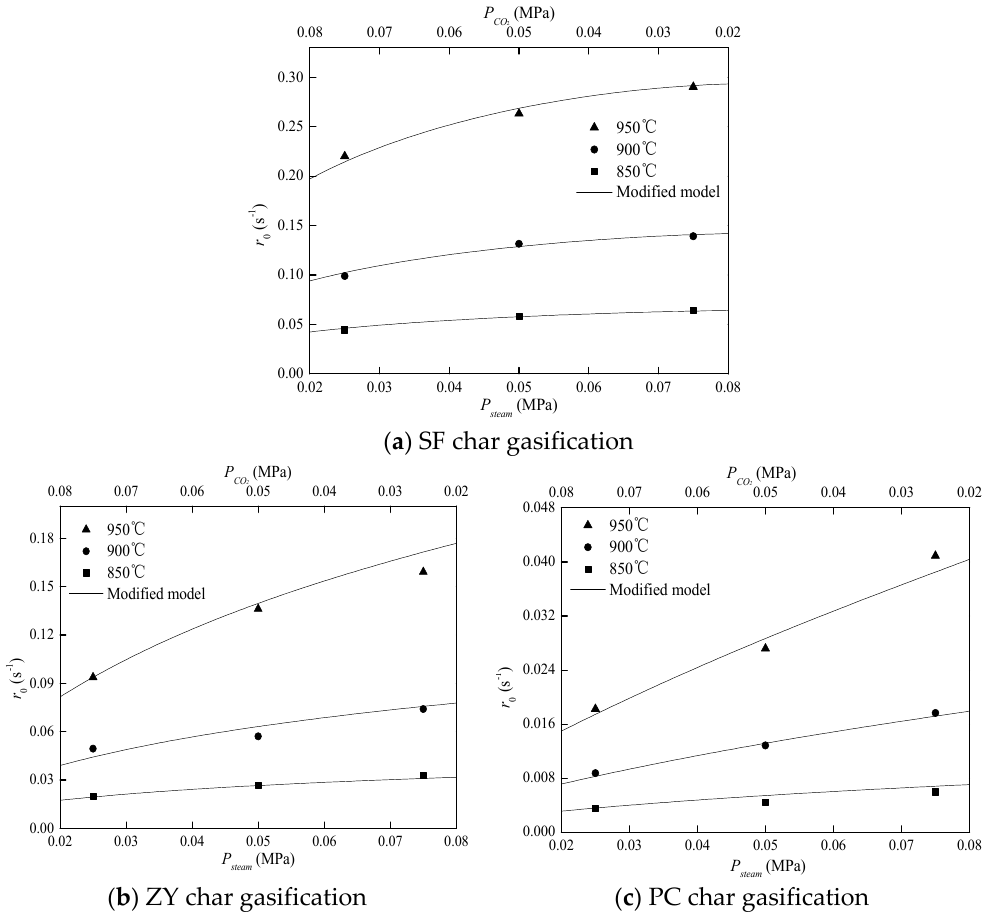
Figure 5. Comparison of experimental data and the modified model.